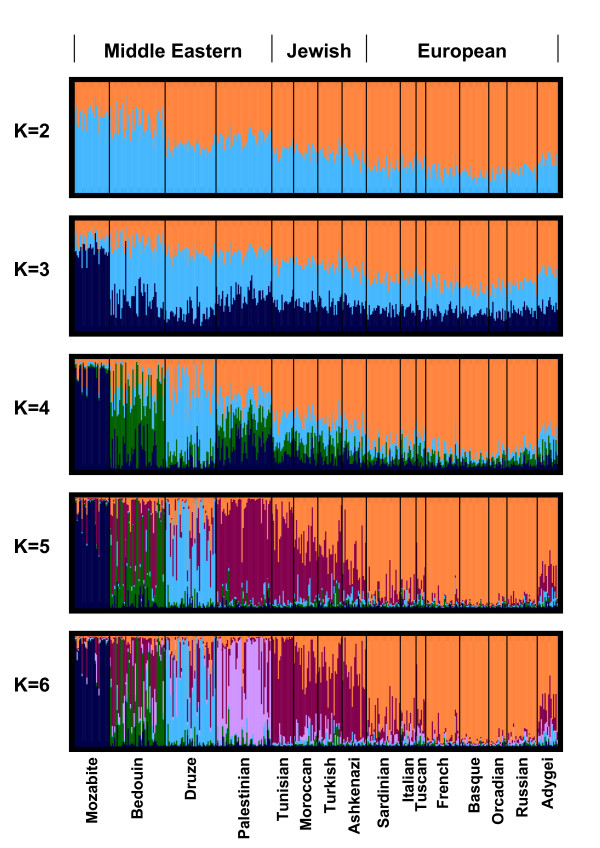
Population structure for European, Jewish, and Middle Eastern populations, inferred with unsupervised clustering. The number of predefined clusters (K) is indicated to the left of each plot. Each individual is represented by a thin vertical line that is partitioned into K colored components according to the inferred membership in K genetic clusters. For each K, only the major mode is shown (obtained in 39 of 40 replicates for K = 2, 40 of 40 replicates for K = 3, 15 of 40 replicates for K = 4, 40 of 40 replicates for K = 5, and 20 of 40 replicates for K = 6).